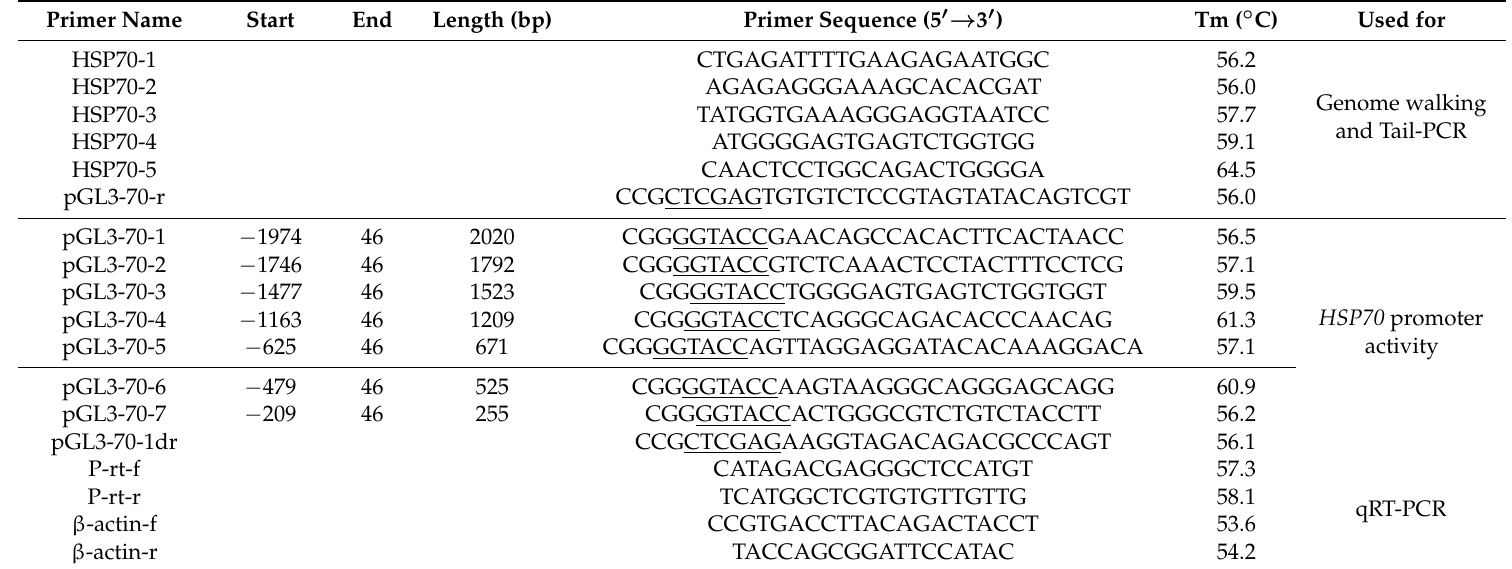
Table 1. Primers used in this